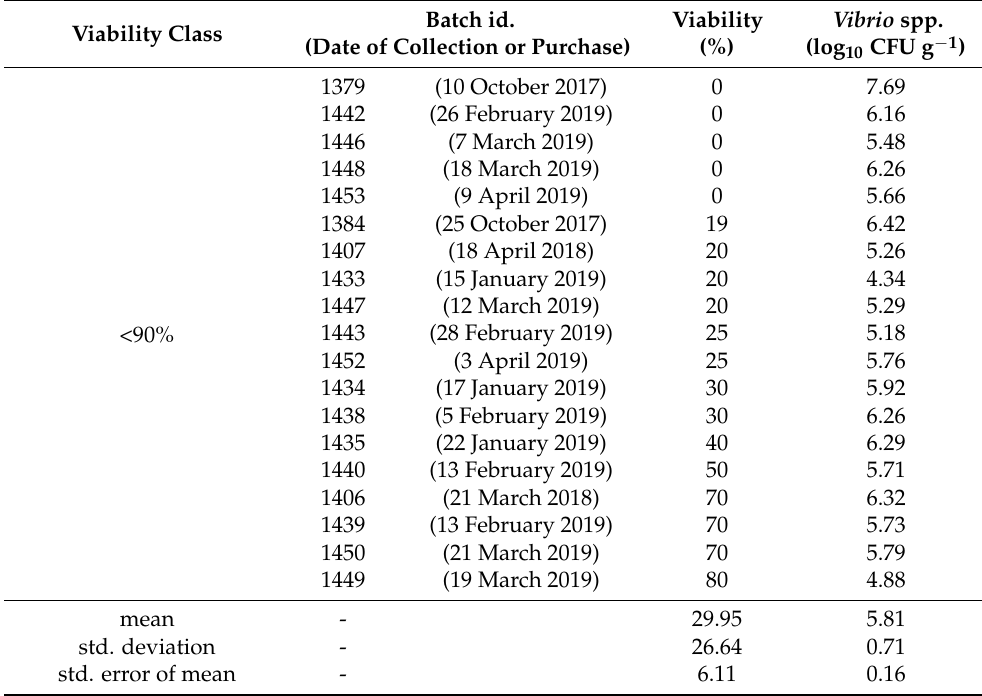
Table 1. Viability of the Tritia mutabilis batches at retail and Vibrio spp. load. Viability